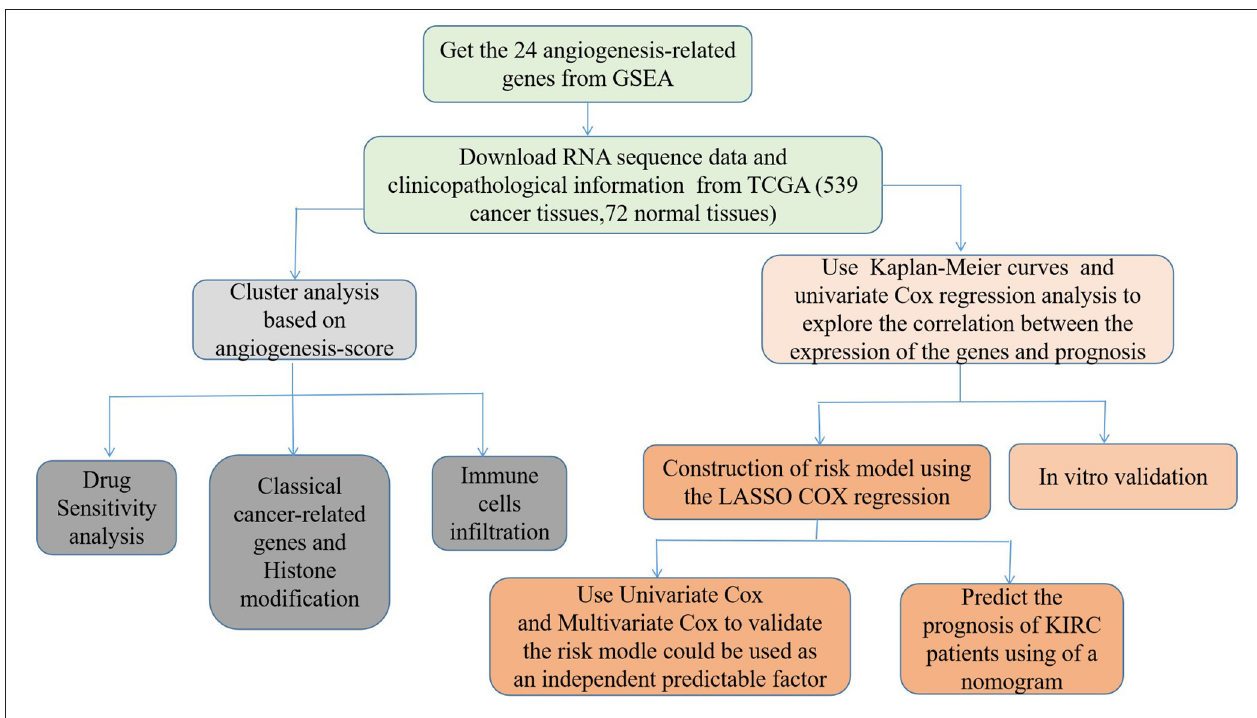
FIGURE 1 | The flowchart of this